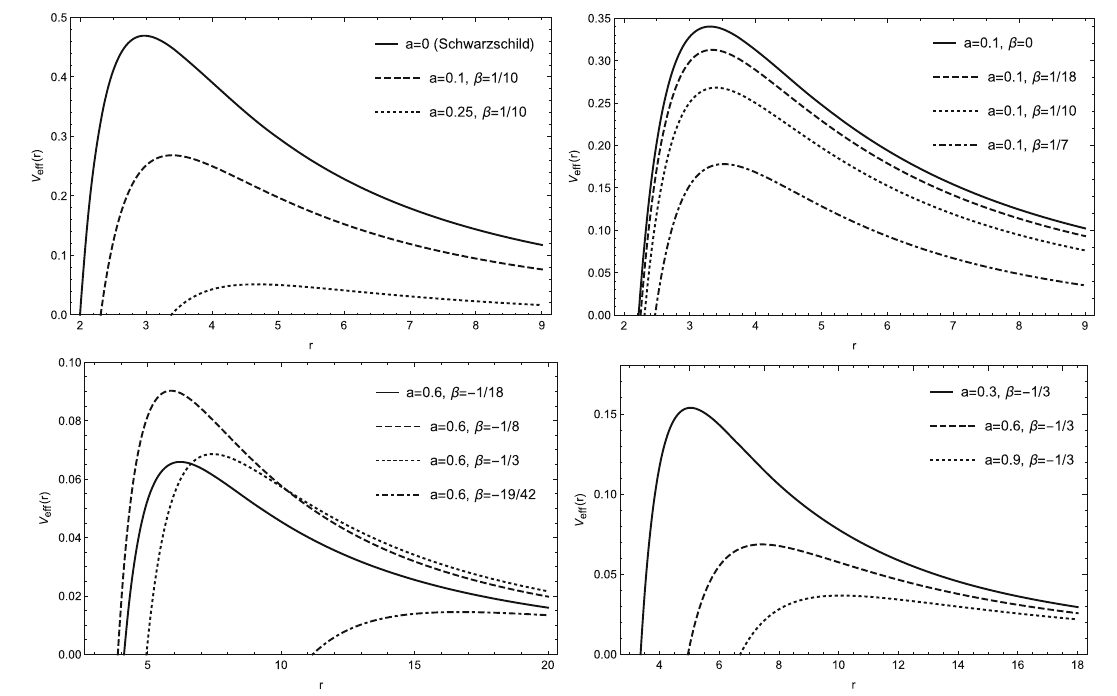
Fig. 2 The effective potential for the different variables with M = 1, in the lower left corner is that the parameter β is variable with a = 0 . 6. l = 3. For β > 0, the picture in the upper left corner is that the param- the figure in the lower right corner is that the parameter a is variable for eter a is variable when β = 1 fixed β = − 1 . The plot in the upper right corner is 10 that the parameter β is variable when a = 0 . 1. For β < 0, the picture